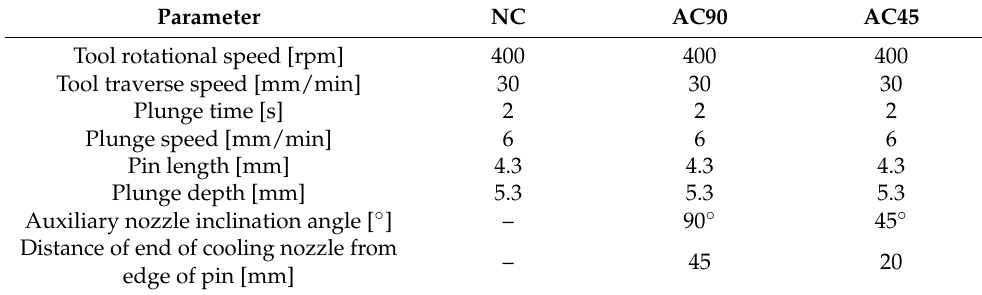
Table 2. Processing parameters of 7075 aluminum